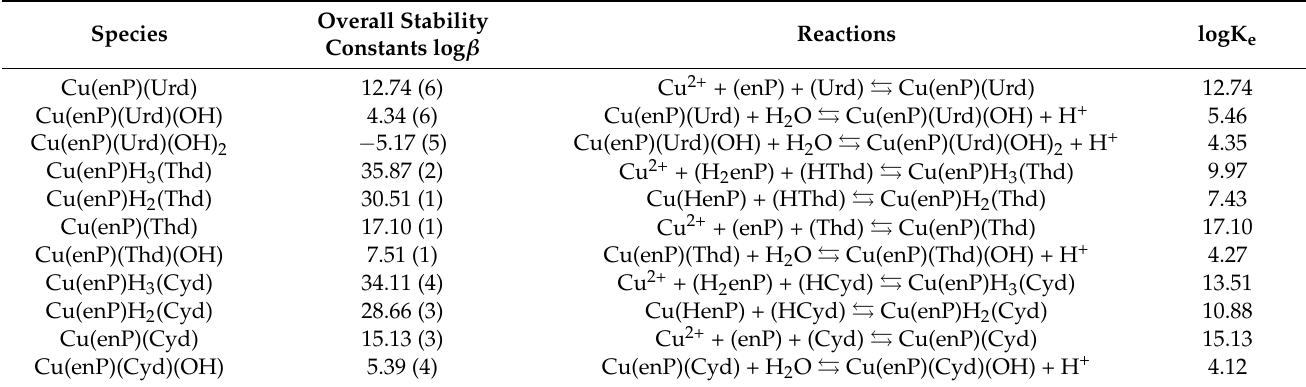
cytidine (logK e = 4.49). For enP, the potential coordination and non-covalent interaction centers were the same as in the binary systems—the phosphate and amine groups. Table 7. Overall and successive stability as well as equilibrium constants of Cu(II) complexes in the Cu(II)/enP/Nuc systems (standard deviation is given in parenthesis).